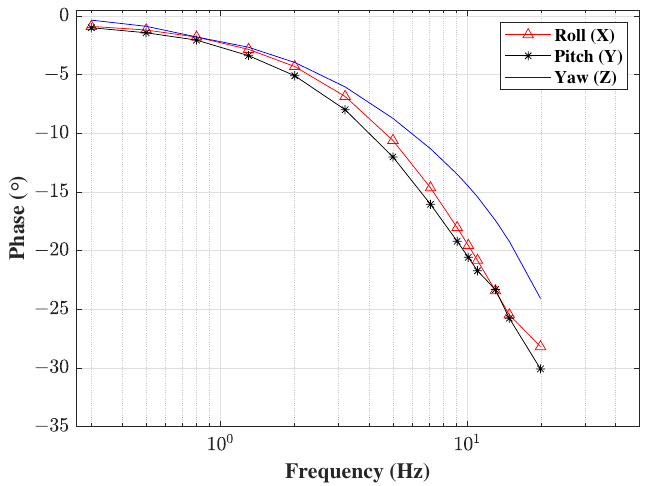
Figure 7. The Bode plot for a rotational describing function under TSMC on SE(3).